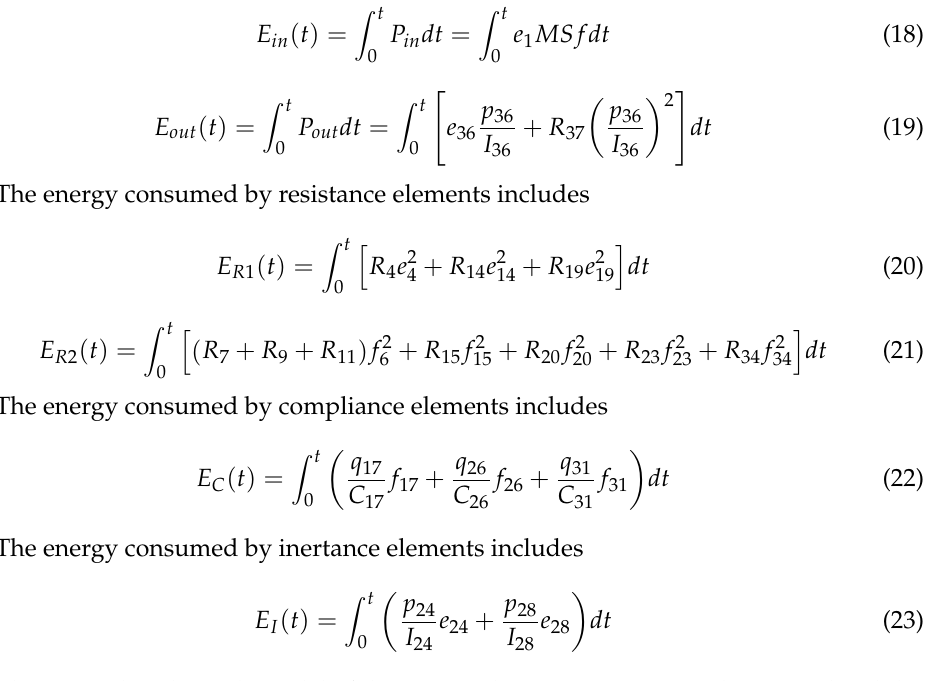
Figure 13. The power bond-graph model of HTD. The system input energy is the motor output energy. The useful energy of the system includes the kinetic energy stored by the load and the energy consumed by the damping of the load. The energy equations for the system are as follows